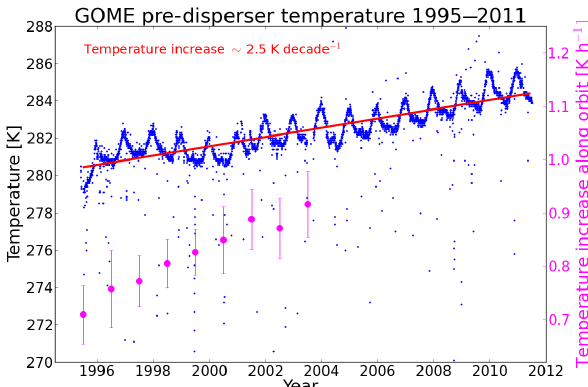
Figure 10. Temperature measured at the pre-disperser prism as a function of time from 1995 to 2011 (blue) and linear fit (red). The temperature increase is about 2.5Kdecade − 1 . Magenta dots de- note the increase in the pre-disperser temperature along one orbit in Kelvinh − 1 (right y axis) for the years 1995 to 2003. Analysis of later years is not possible due to the tape recorder failure (incom- plete